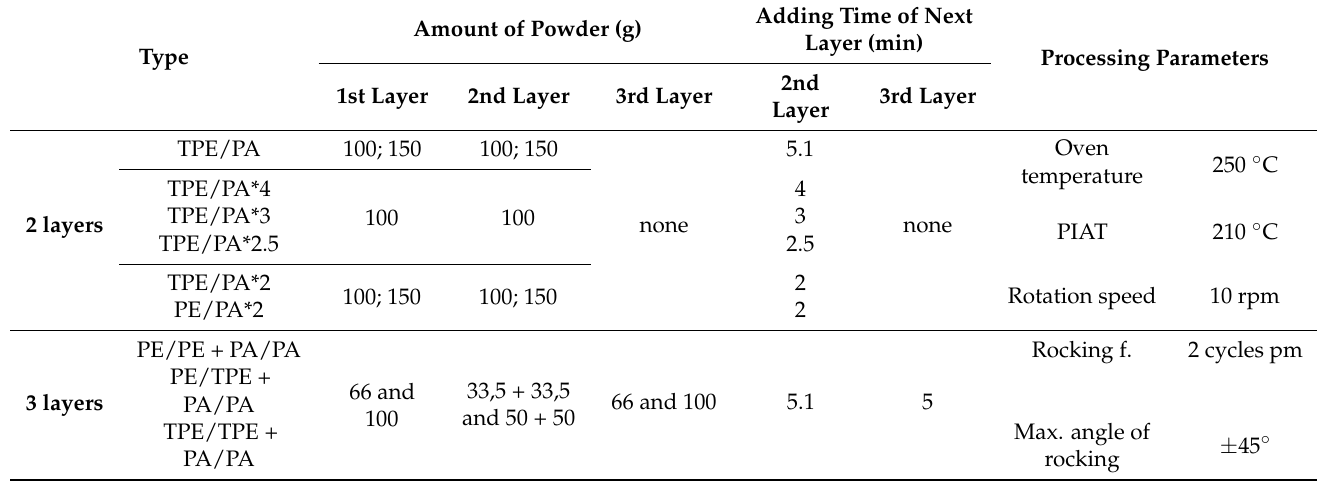
Table 2. Summary of the specimen preparation. Plasma treated polyethylene (TPE), polyamide (PA), polyethylen (PE).